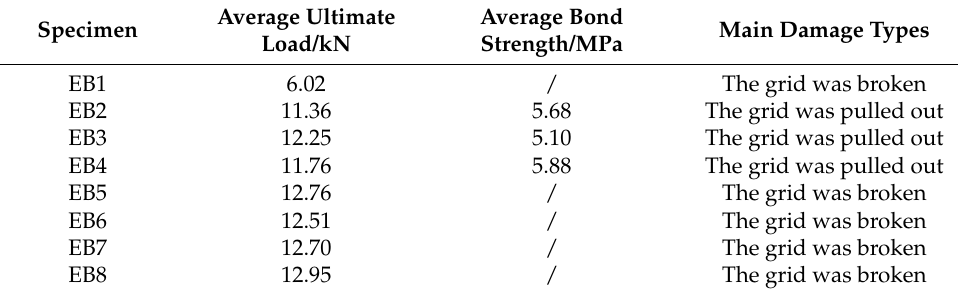
Table 5. The main test results of each drawing specimen set.